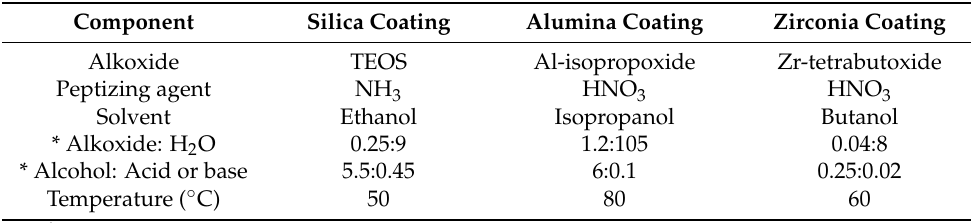
Table 2. Materials and experimental conditions used for coating solution synthesis.